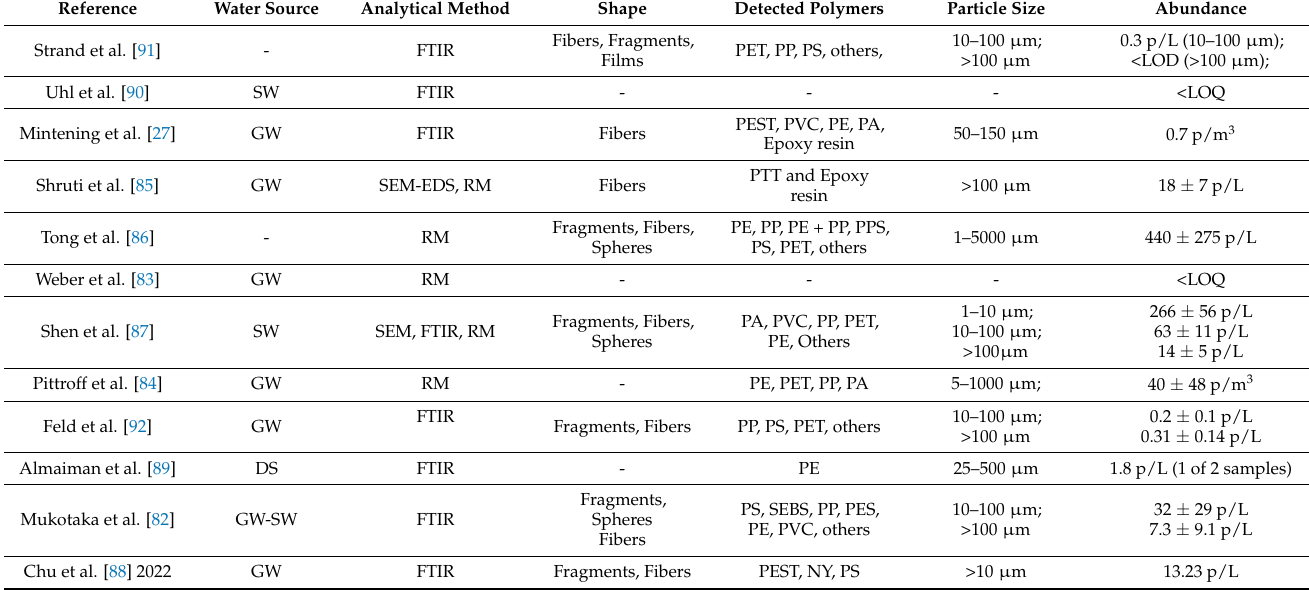
Table 2. Analytical methods, characteristics, and abundance of MPs detected in TW and DWTP. PET: polyethylene terephthalate; PP: polypropylene; PE: polyethylene; PS: polystyrene; PVC: polyvinyl chloride; PA: polyamide; PAM: polyacrylamide; PPS: polyphenylene sulfide; PEST: (PES − polyether sulfone + PET); SW: surface water; GW: groundwater; DW: drinking